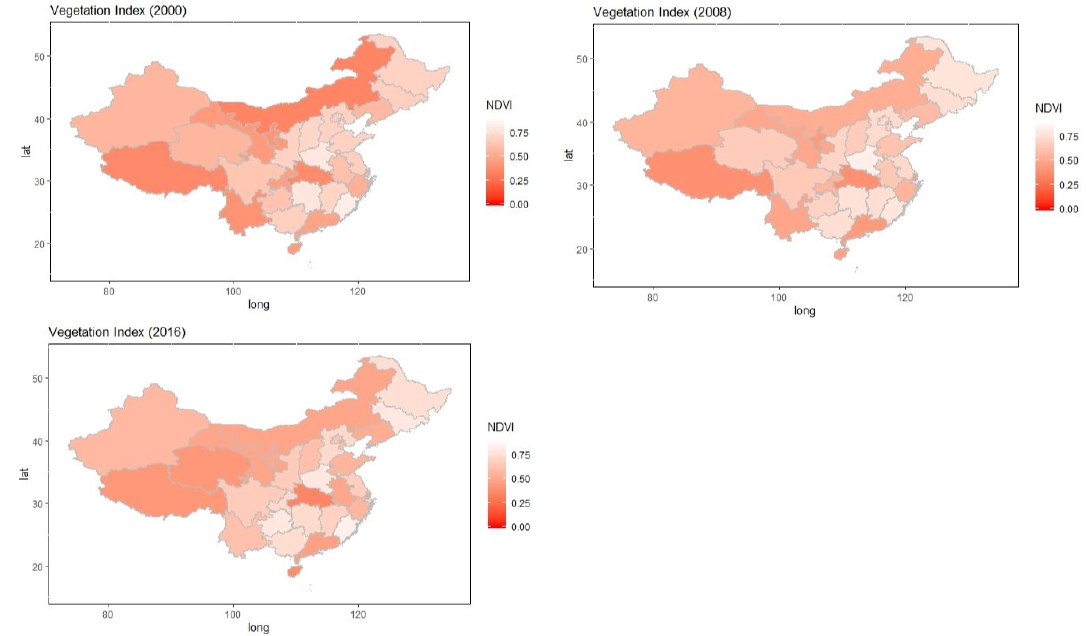
Figure 7. Normalized Difference Vegetation Index (NDVI) in different years in the Chinese territory (data in the Hong Kong, Macao, and Taiwan area are not indicated due to data unavailability). Table 2. NDVI of all provincial capitals and its variation from 2000 to 2016.